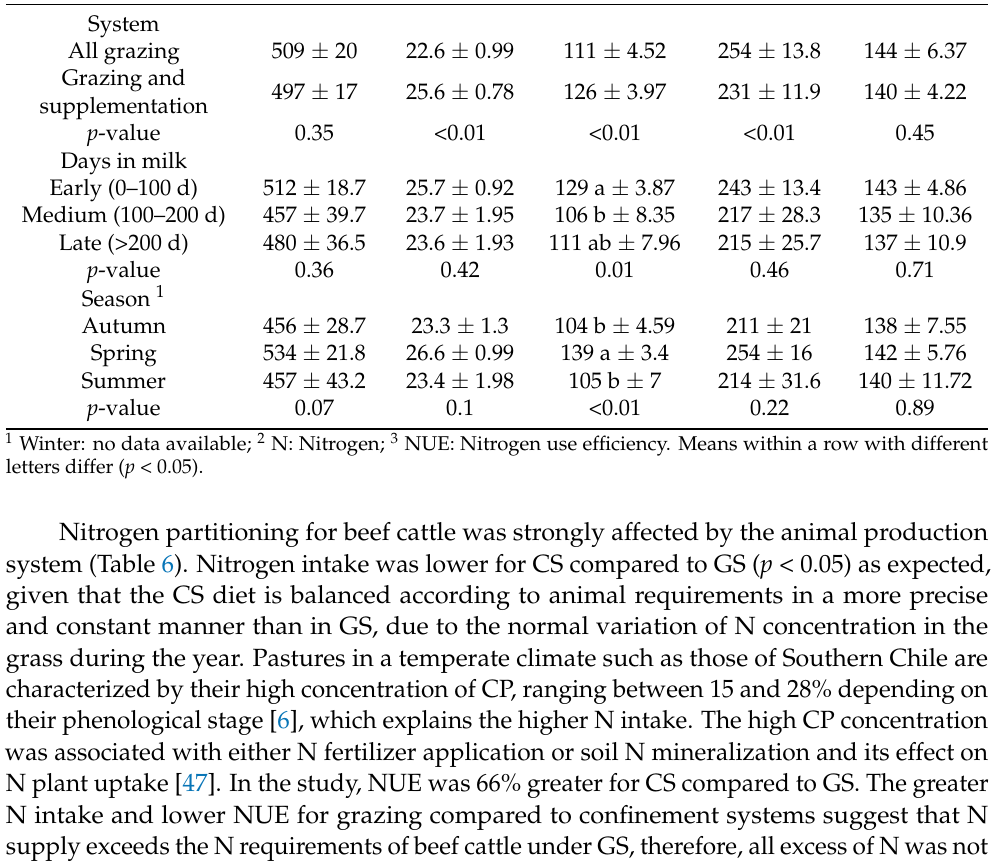
Urinary N Dung N 2 N Milk g Excretion g Intake g NUE 3 % N/d N/d